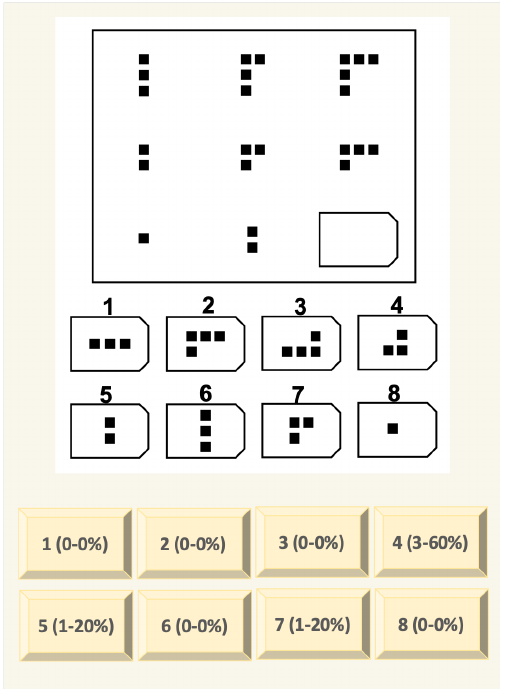
Figure 2. Users’ interface for the task in the computer-mediated-communication (CMC) condition. Users’ interface of the Raven’s Advanced Progressive Matrices test (RAPM) that participants have faced in the computer-mediated-communication experimental condition (CMC). In the buttons at the bottom of the interface, other to be represented the number corresponding to the eight answer options for the matrix, there are both the number and the percentage of teammates who have given that